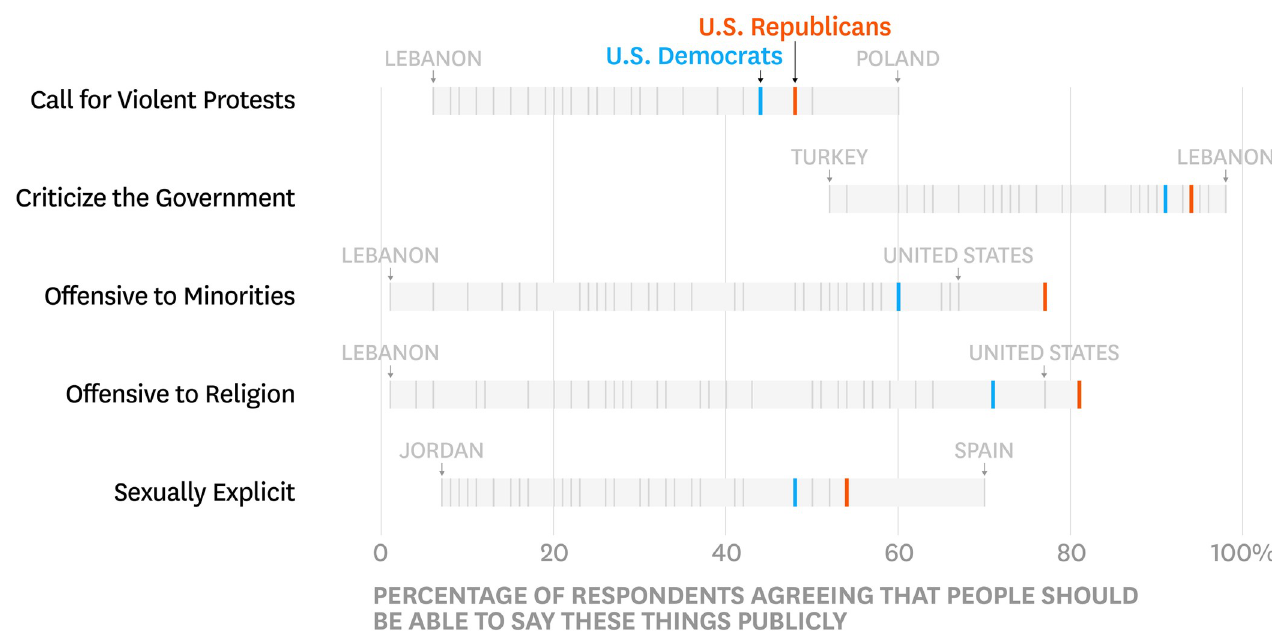
Fig 4. Freedom of speech issues: Democrats and republicans in global context.